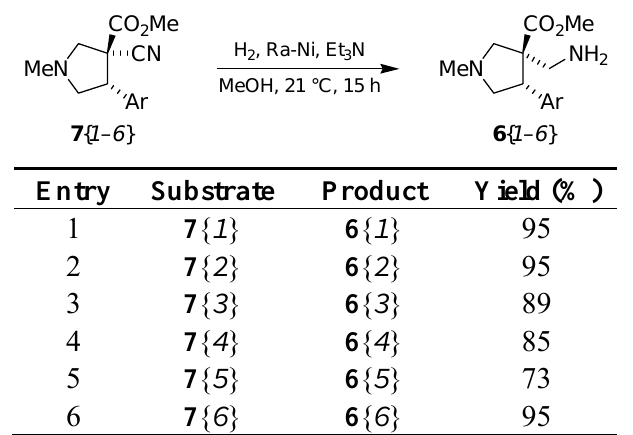
Table 3. Reduction of the cyano group from the α -cyano esters 7 .